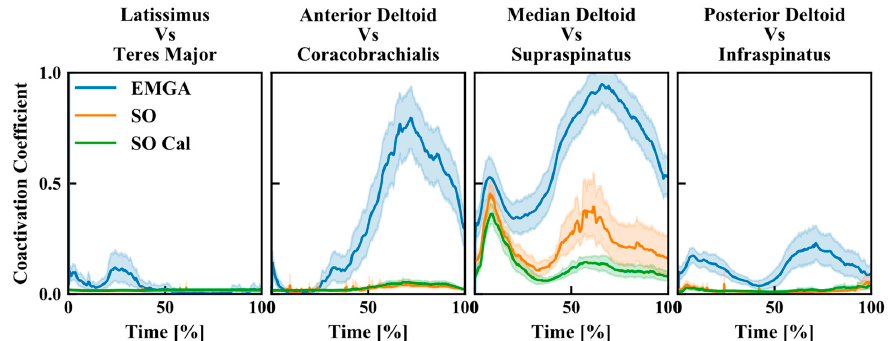
Figure 6. Coactivation coefficients between various muscle pairs (solid line: mean value, shaded region: 95% confidence interval) as predicted by EMGA (blue), SO (orange) and SOcal (green): the higher the coefficient, the higher is the muscle pair’s coactivation. Appl. Sci. 2020 , 10 , x FOR PEER REVIEW